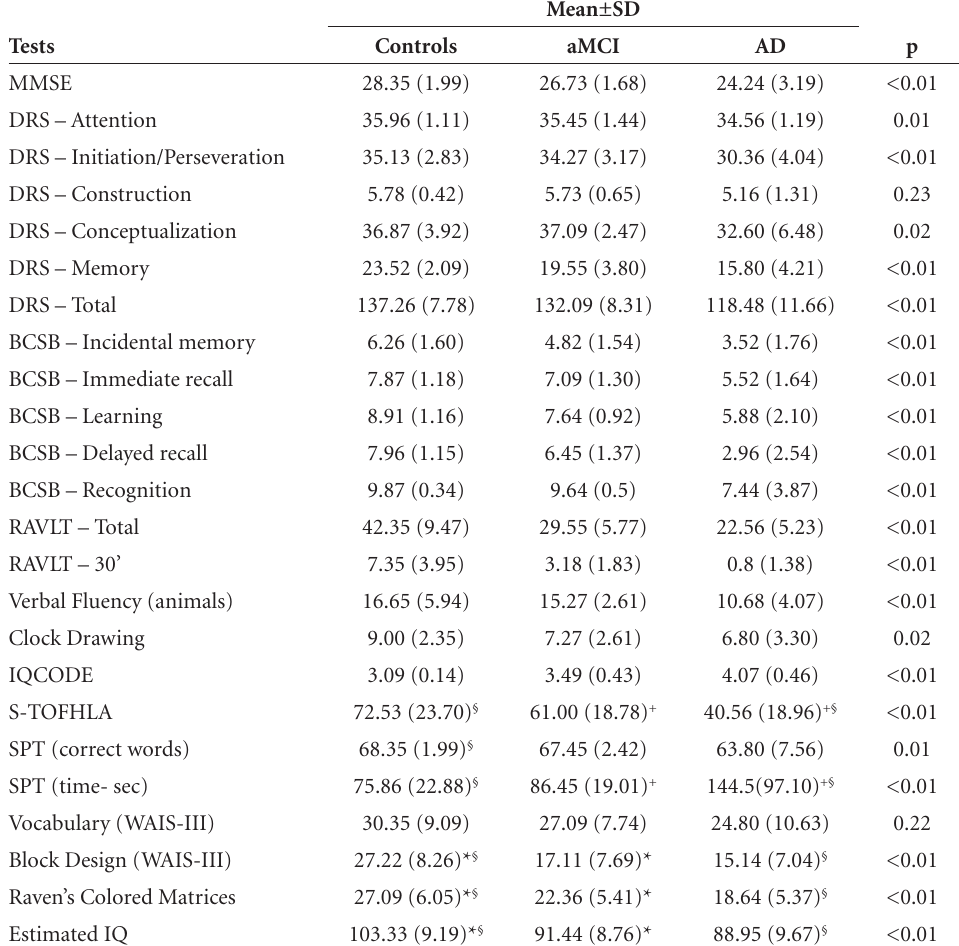
Table 2. Performance of controls, aMCI and AD patients on the